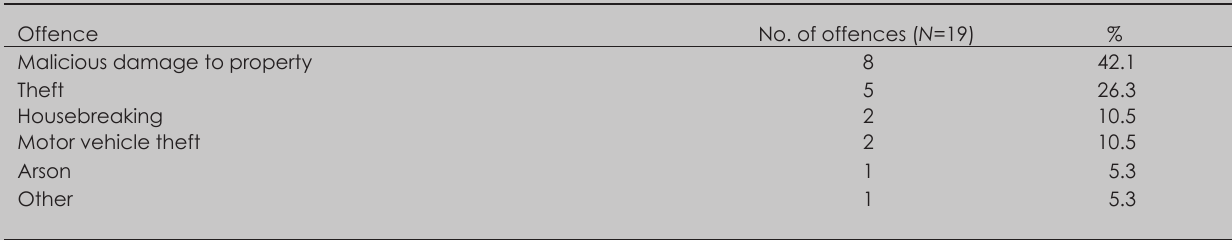
Table II. Offences committed against